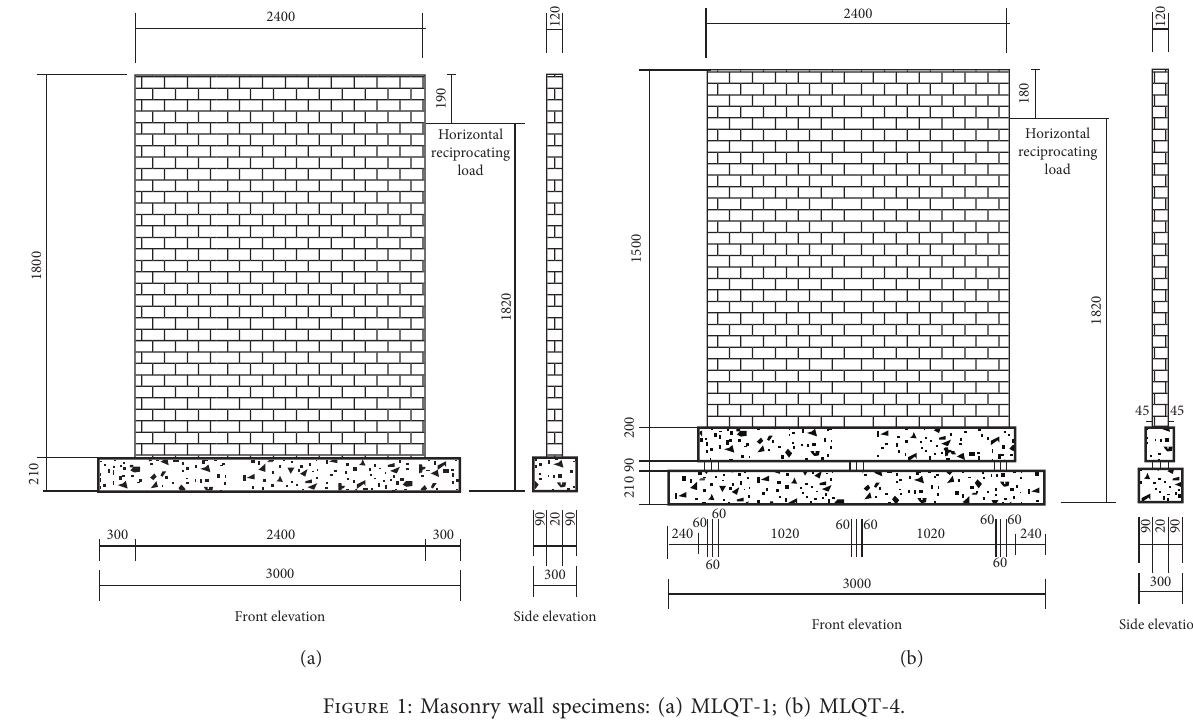
Figure 1: Masonry wall specimens: (a) MLQT-1; (b) MLQT-4.